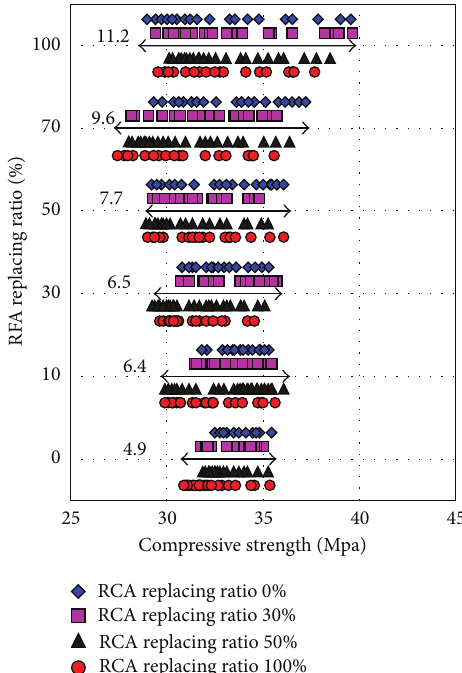
Figure 8: Deflection of compressive strength with RCA and RFA replacing ratios.